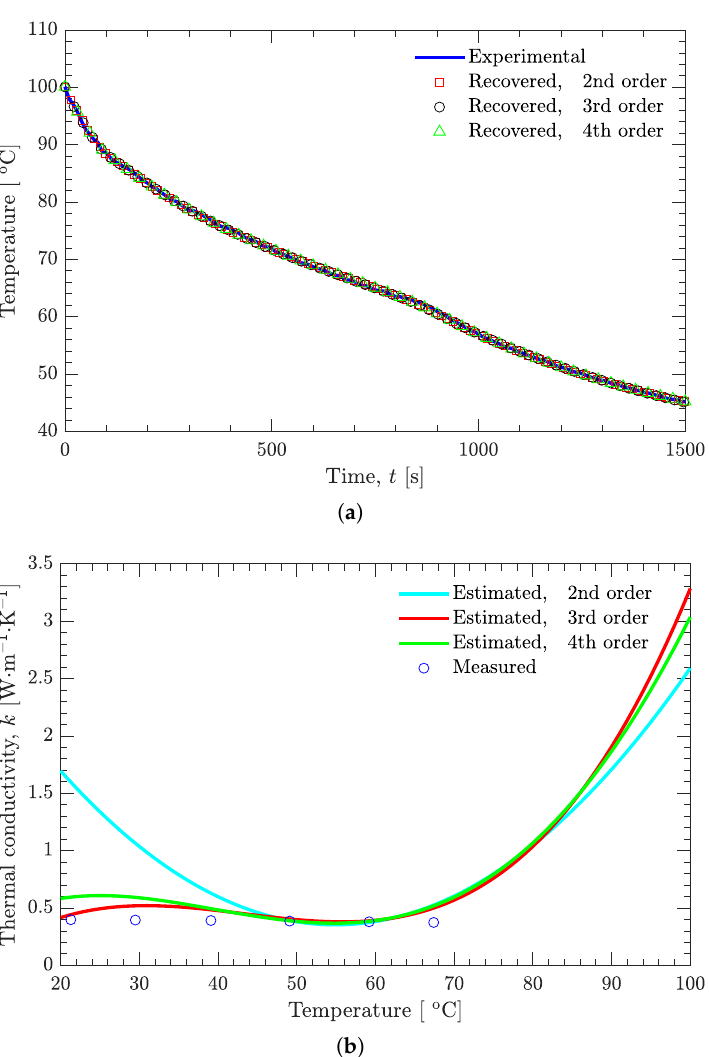
Figure 10. Effect of polynomial order on the recovered temperatures and on the estimated thermal conductivity. ( a ) Temperature. ( b ) Thermal conductivity.